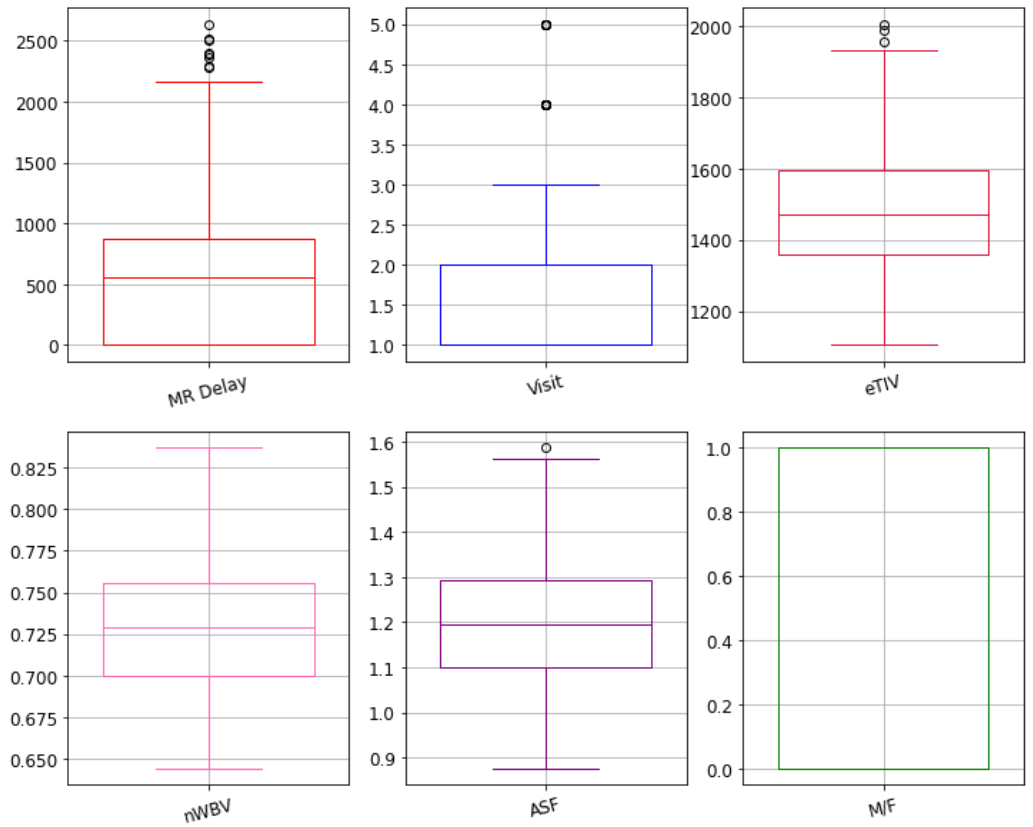
Figure 4. Box plot representation of the features with high correlation.